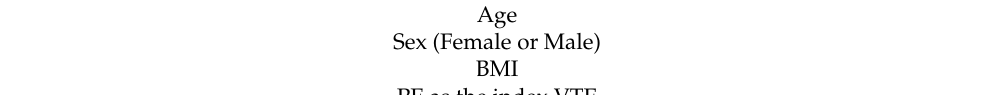
Table 6. Prediction factors of recurrent VTE risk and anticoagulant-associated bleeding risk [18]. Ambivalent Prediction Factors of Anticoagulant-Associated Bleeding and Recurrent